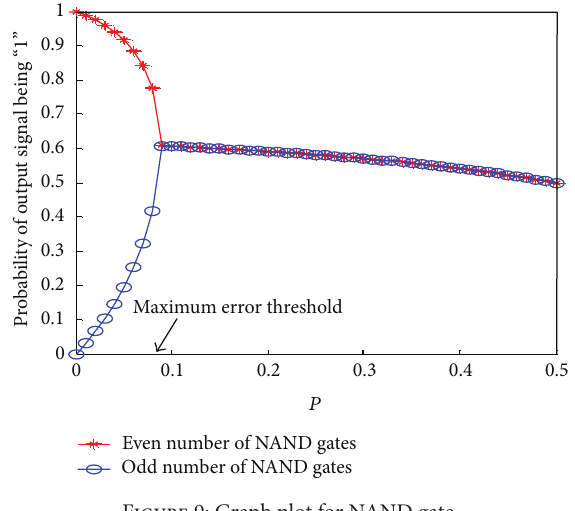
Figure 9: Graph plot for NAND gate.